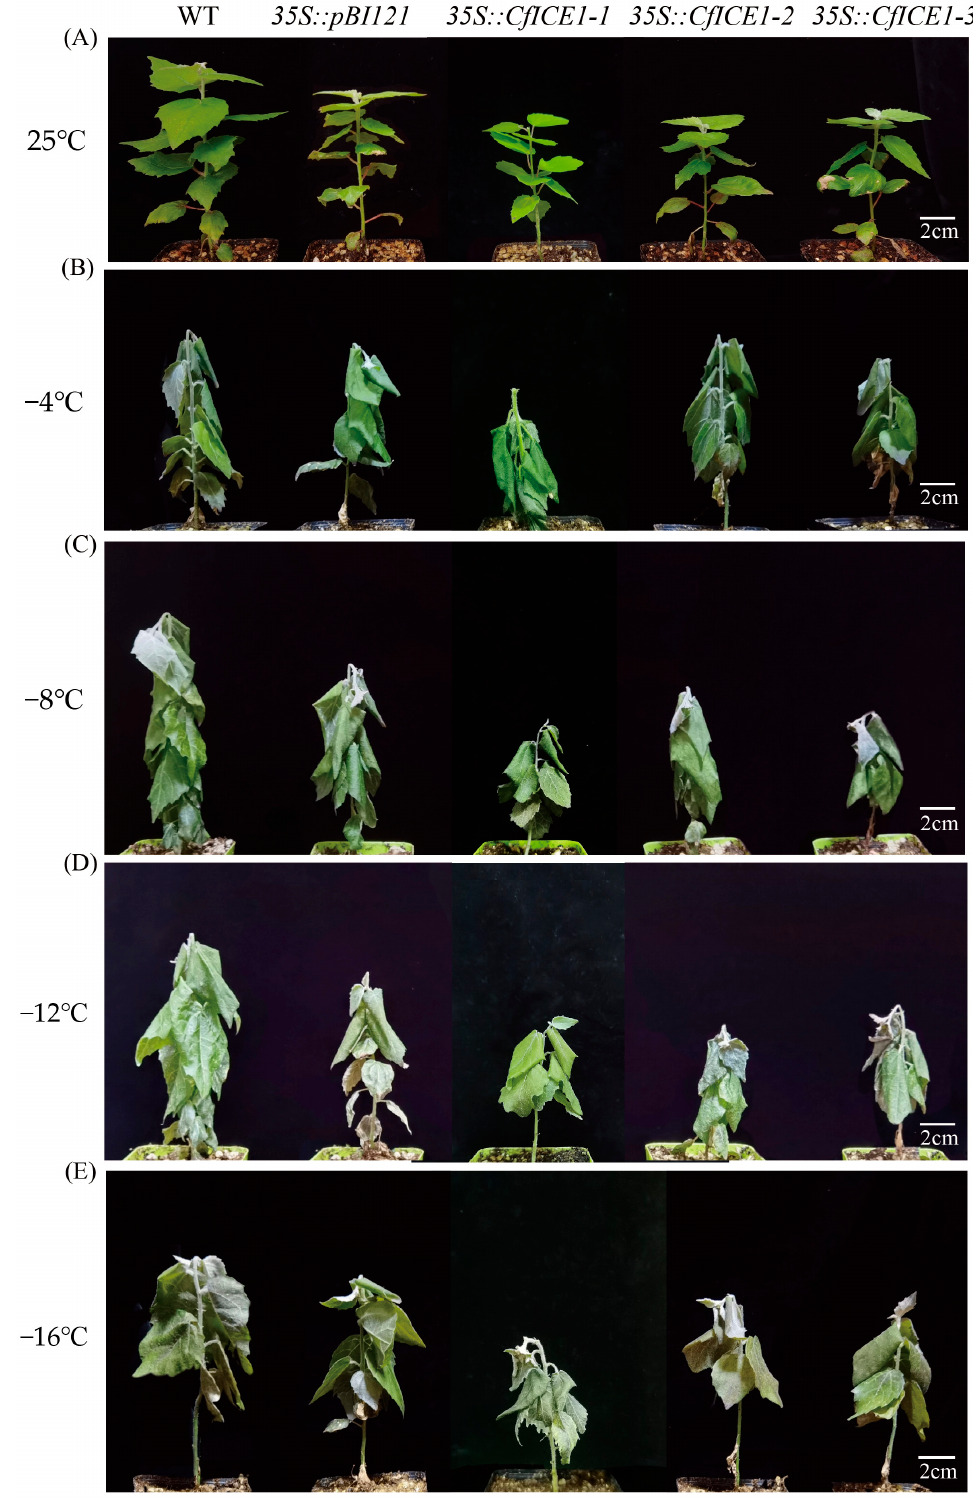
Figure 2. Phenotypic changes of transgenic, empty vector and wild-type poplar lines under cold stress at ( A ) 25 °C, ( B ) − 4 °C, ( C ) − 8 °C, ( D ) − 12 °C and ( E ) − 16 °C.